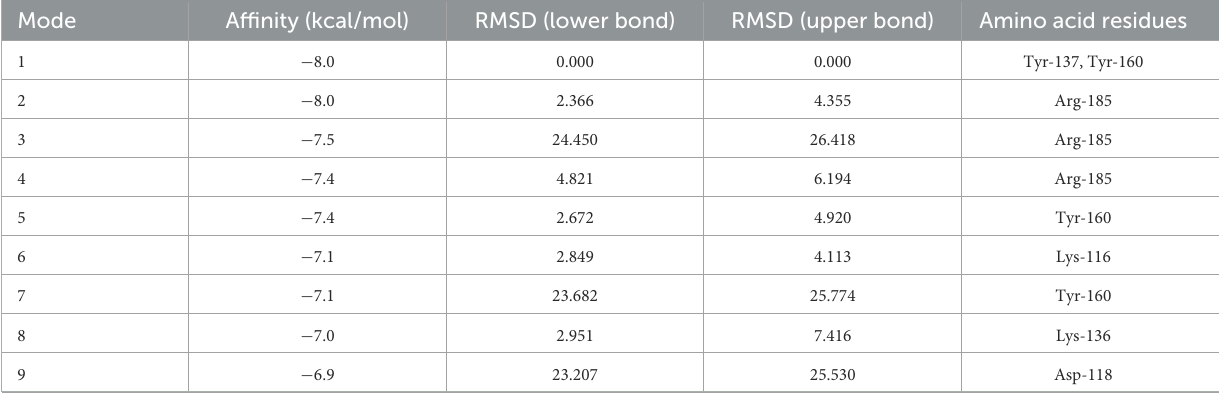
TABLE 3 Molecular docking simulation of agomelatine to BSA results.